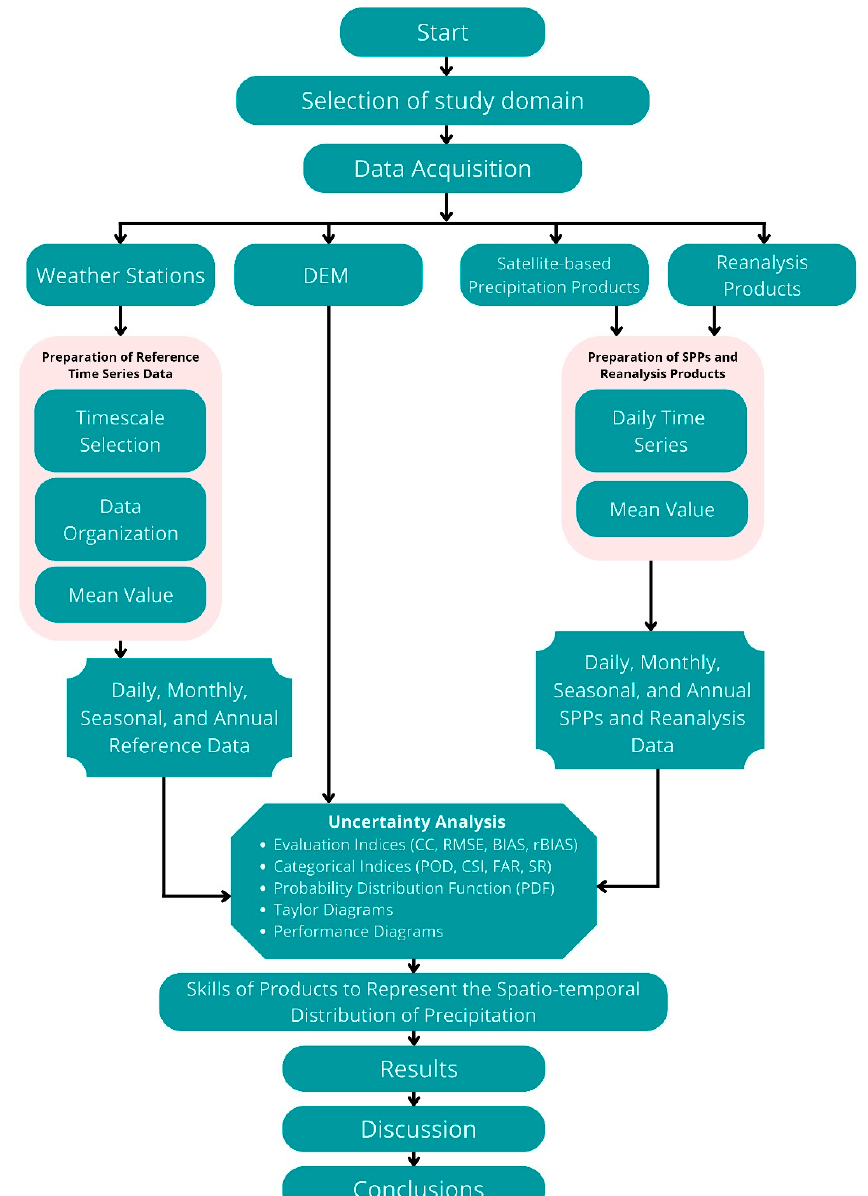
Figure 3. Layout of the procedure to evaluate the performances of precipitation products over Pakistan.